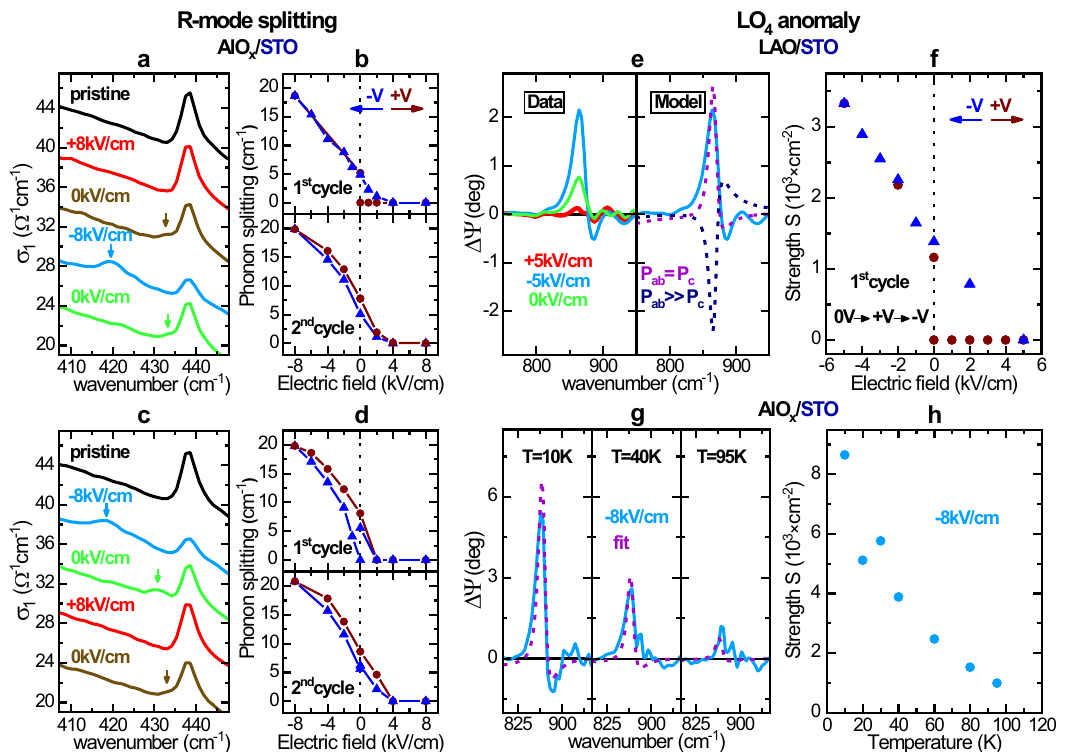
Fig. 1 Infrared ellipsometry study of phonon anomalies due to the electric- fi eld-induced polar moment. a Spectra of the optical conductivity, σ 1 , showing the asymmetric R-mode splitting due to an in-plane polarization P ab for gate-voltage cycles 0 V → + V → − V and b the corresponding hysteresis loops for the magnitude of the R-mode splitting (and thus of P ab ) at 10 K. c Spectra and d hysteresis loops of the R-mode splitting for the reverse voltage cycling direction, i.e. 0 V → − V → + V. e , f Anomaly at the longitudinal optical (LO 4 ) edge. e The difference spectra of the ellipsometric angle ΔΨ = Ψ exp – Ψ 0V, pristine at the LO 4 edge show the signatures of an infrared-active transverse optical (TO) mode that is induced at modeled by assuming a polarization with a sizeable vertical component (dashed purple), instead of a polarization of pure horizontal character (dashed dark blue). f Corresponding voltage loops of the oscillator strength, S, of the fi eld-induced TO mode. g , h Temperature dependence of the LO 4 anomaly. g Spectra of the fi eld-induced TO mode (cyan) together with the fi t (dashed purple) at selected temperatures. h Temperature dependence of S for the fi eld-induced TO mode (at − 8